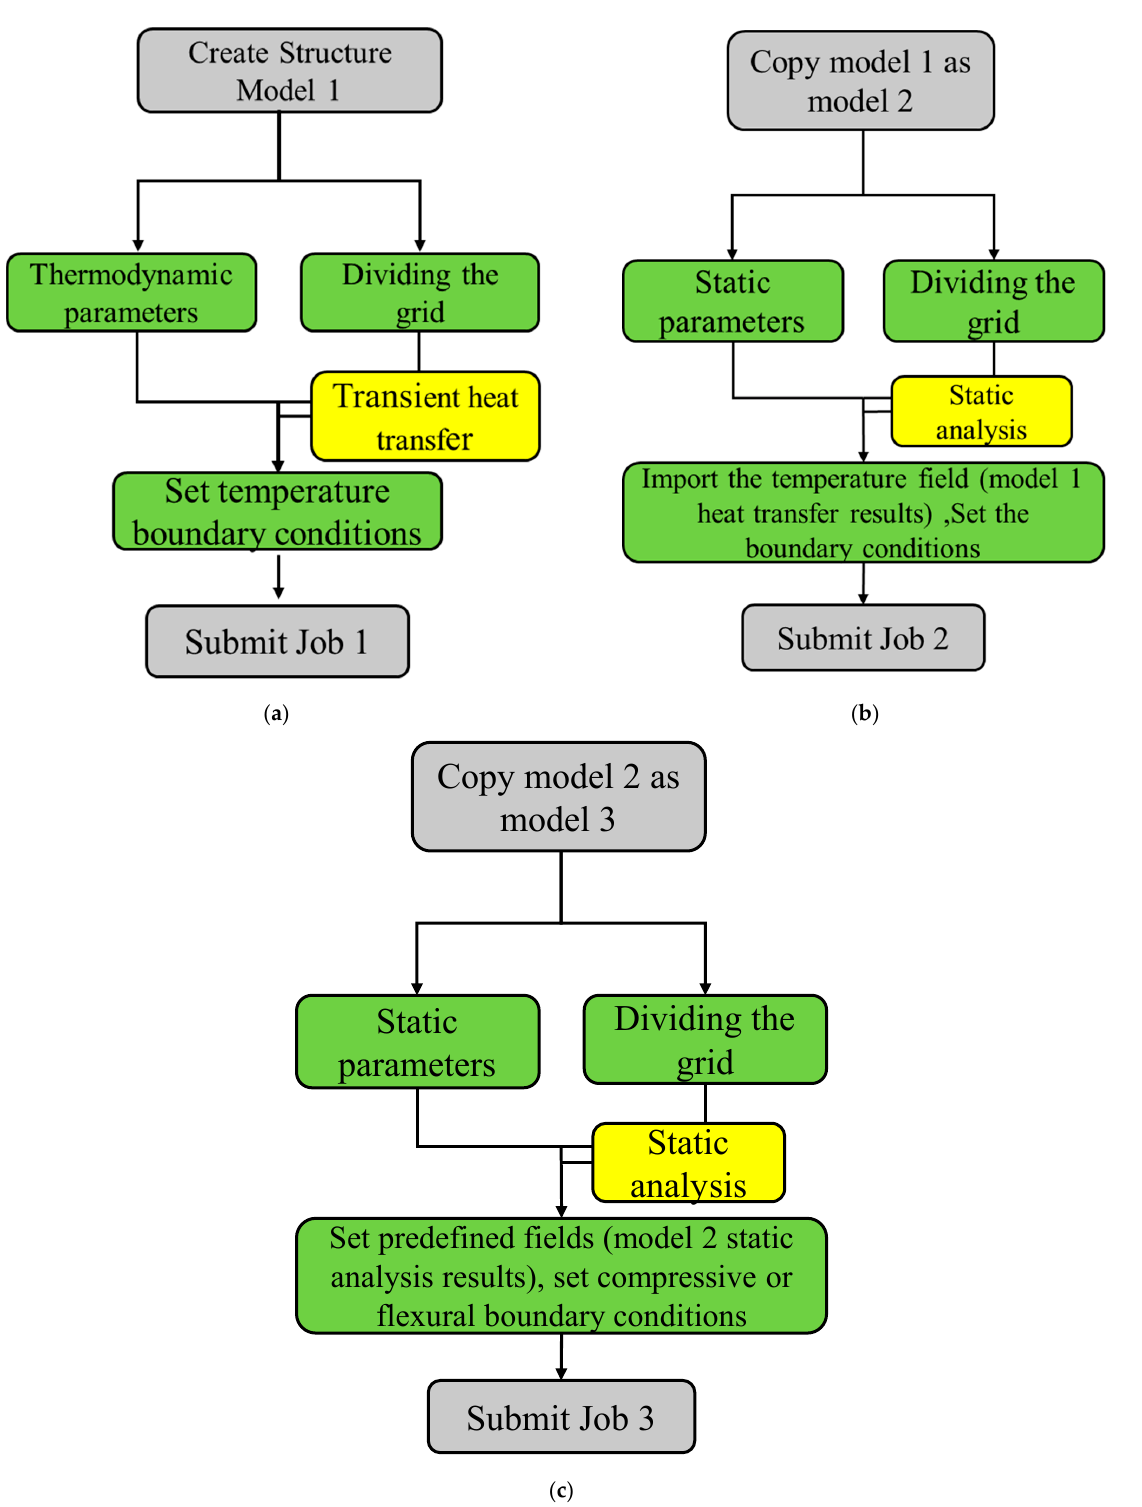
Figure 11. Numerical simulation flow chart of freeze-thaw temperature conduction behavior and compressive and flexural mechanical behavior of FRP-reinforced concrete: ( a ) transient heat transfer analysis; ( b ) simulation of freeze–thaw process; ( c ) simulation of mechanical